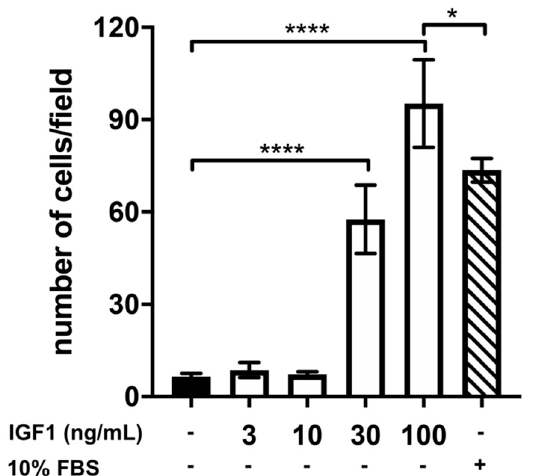
Figure 4. Effect of different concentrations of insulin-like growth factor 1 (IGF1) on GN11 cell migration. Data are expressed as mean ± SD, n = 8. One experiment representative of three separate experiments is shown. * p < 0.05; **** p < 0.0001 (One-way ANOVA followed by the Dunnett post-hoc test).